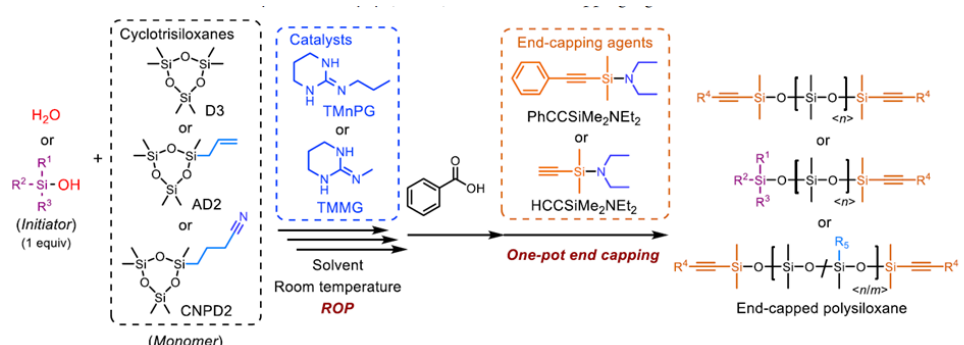
Figure 22. Precise Synthesis of Alkynylsilyl-Terminated Polysiloxanes by ROP of Cyclotrisiloxanes Using Water or a Silanol as an Initiator, Guanidines as Catalysts, and alkynyl(amino)silanes as End-Capping Agents (adapted with permission from Ref. [111]. 2021, Fuchise, K)